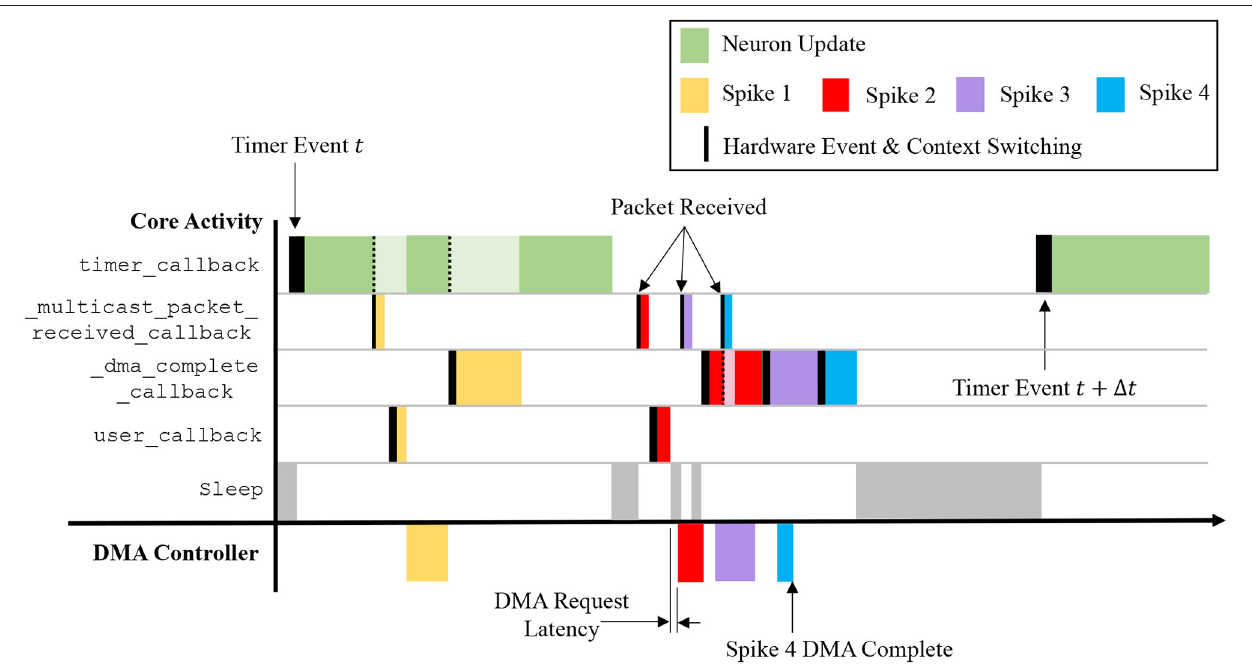
FIGURE 9 | Interaction of callbacks shown over the time period between two timer events. Four spike events are processed representing the scenarios: receiving a packet while processing a timer event; receiving a packet while the core is idling; and receiving a packet while the spike processing pipeline is active. Note that a lighter color shade indicates suspension of a callback, which is resumed on completion of higher priority tasks.